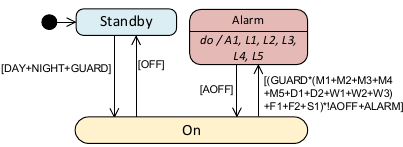
Figure 11. SHS—a UML state machine diagram on the highest hierarchy level.